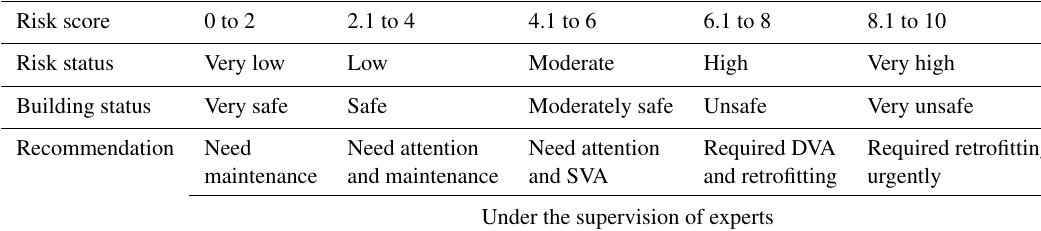
Table 5. Risk score computation; source: adapted from Chouhan et al.